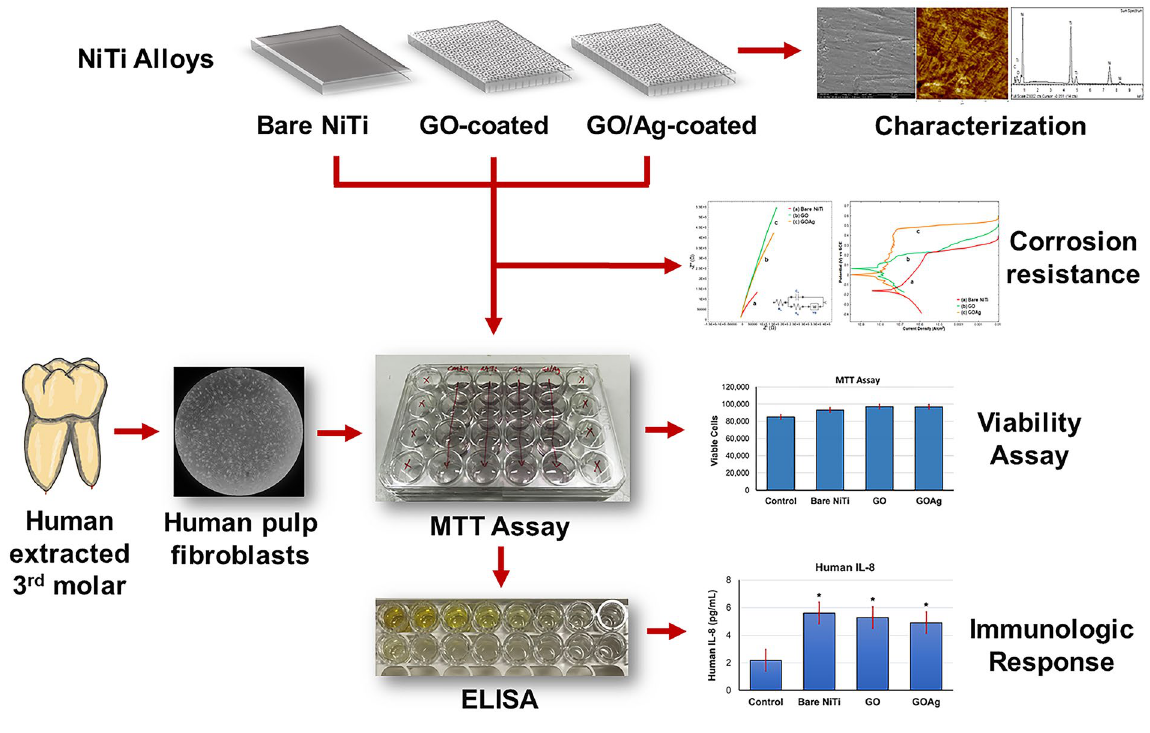
Figure 1. The overview of the